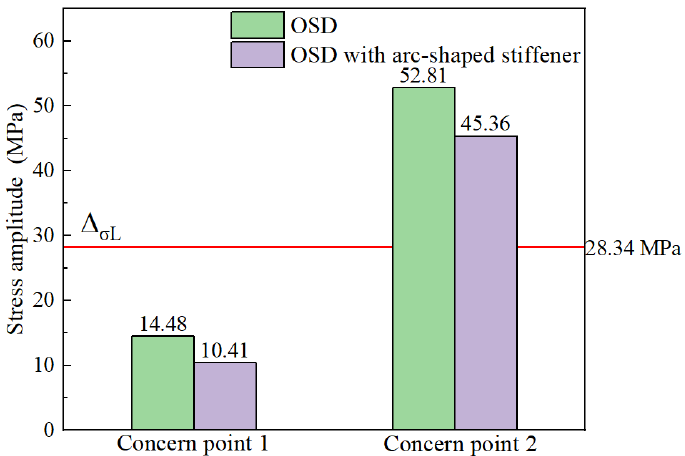
The fatigue limit of concern points ∆ σ L is 28.34 MPa according to the China Highway Steel Bridge Code [37]. The stress amplitude value of concern points is listed in Figure 9.